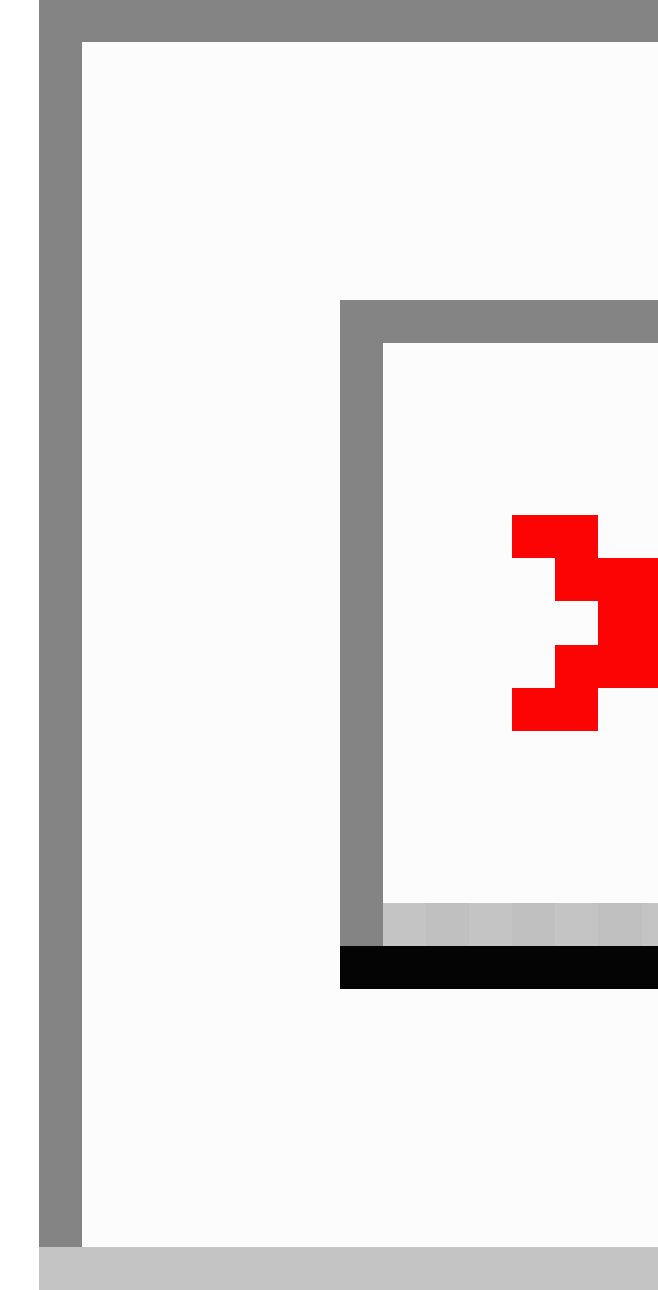
Figure 2. Training participant recruitment and screening